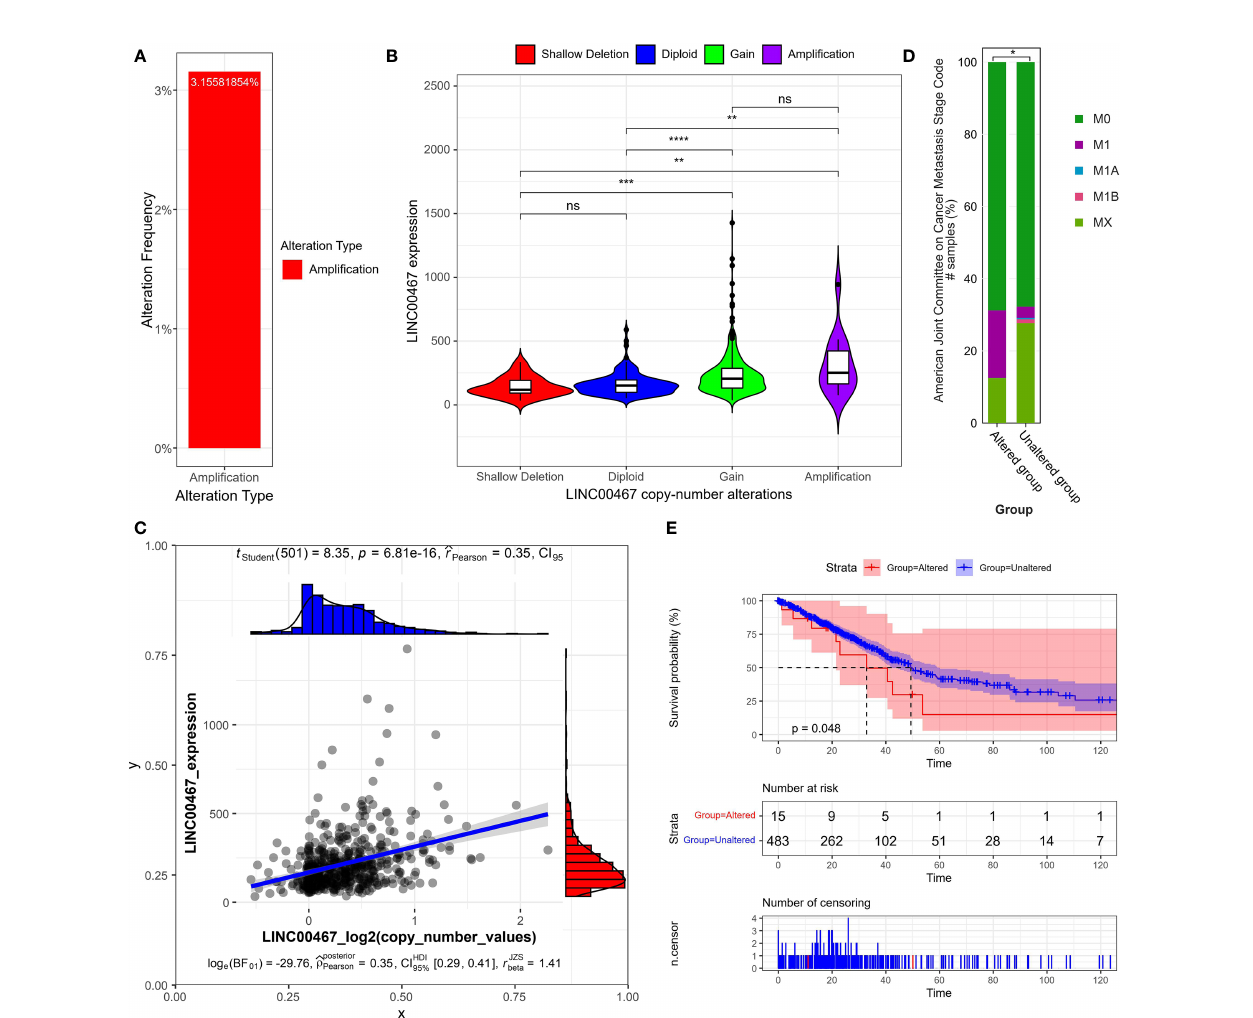
FIGURE 1 | LINC00467 expression correlates with DNA copy number alterations in LUAD. (A) The percentage of patients with DNA copy number ampli fi cation of LINC00467 in the LUAD cohort (The Cancer Genome Atlas [TCGA], PanCancer Atlas). (B) LINC00467 expression in LUAD patients across different types of DNA copy number alterations. As de fi ned by GISTIC2.0, Deep Deletion indicates a deep loss, possibly a homozygous deletion; Shallow Deletion indicates a shallow loss, possibly a heterozygous deletion; Diploid indicates normal; Gain indicates a low-level gain (a few additional copies, often broad); Ampli fi cation indicates a high-level ampli fi cation (more copies, often focal. Please see: https://docs.cbioportal.org/1.-general/faq#dna-mutations-copy-number-and-fusions. **P < 0.01; ***P < 0.001; ****P < 0.0001; ns, no signi fi cance. (C) Correlation between LINC00467 expression and DNA copy number. (D) The percentage of patients in different metastasis stages with altered versus unaltered LINC00467 DNA copy numbers. According to “ The Eighth Edition Lung Cancer Stage Classi fi cation ” (31): M0 indicates no distal metastasis; M1A indicates intrathoracic metastasis or pleural effusion or pericardial effusion or contralateral lung nodules/pleural nodules; M1B indicates single extrathoracic metastasis in a single organ; MX indicates metastasis cannot be measured. *P < 0.05. (E) Overall survival of patients with altered versus unaltered LINC00467 DNA copy numbers. The horizontal axis indicates the overall survival time in months, and the vertical axis indicates the survival